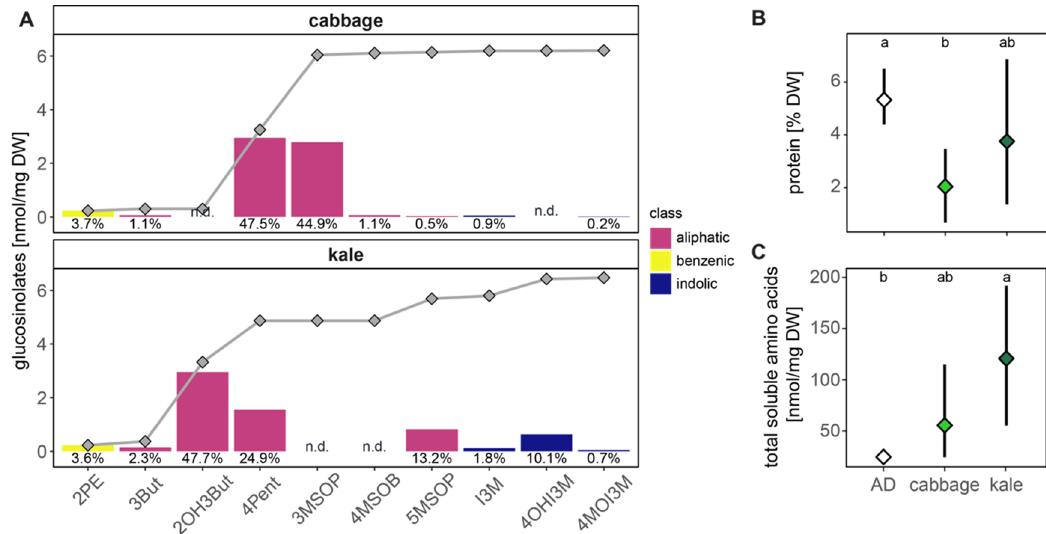
Figure 1. Glucosinolate ( A ), protein ( B ) and soluble amino acid content ( C ) of the food plants and artificial diet (AD). ( A ) Absolute amounts of single glucosinolates [nmol/mg DW] detected in cabbage ( n = 6) and kale ( n = 5) are plotted as bars, the colour refers to the class of the glucosinolate: benzenic, aliphatic or indolic. The contribution of that structure to the total glucosinolate amount is printed as percentage below the corresponding bar. The dots represent the accumulated means of glucosinolates. ( B ) Soluble protein [% DW] of the diets ( p = 0.031) and ( C ) total soluble amino acids [nmol/mg DW] ( p = 0.011) plotted as mean ± 95% confidence interval. Tukey letter denoted a statistical difference of 0.05. Mean, standard deviations and statistical details for all analytes are in Table S1. AD = artificial, diet, DW = dry weight, n.d = not detected; glucosinolate side chains: 2PE = 2-phenylethyl, 3But = 3-butenyl, 2OH3But = 2-hydroxy-3-butenyl, 4Pent = 4-pentenyl, 3MSOP = 3-(methylsulfinyl)propyl, 4MSOB = 4-(methylsulfinyl)butyl, 5MSOP = 5-(methylsulfinyl)pentyl, I3M = indol-3-ylmethyl, 4OHI3M = 4-hydroxy-indol-3-ylmethyl, 4MOI3M = 4-methoxyindol-3-ylmethyl.